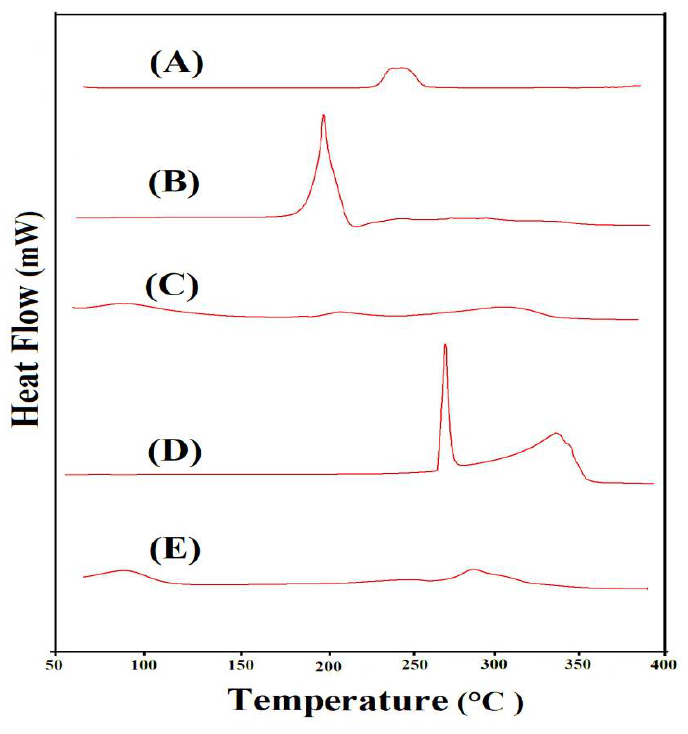
Figure 4. DSC of (A) ASPA, (B) AMPS, (C) ASPA-pAMPS microgels (AFn-3), (D) TP, and (E) loaded Figure 4. DSC of ( A ) ASPA, ( B ) AMPS, ( C ) ASPA-pAMPS microgels (AFn-3), ( D ) TP, and ( E ) loaded ASPA-pAMPS microgels ASPA-pAMPS microgels (AFn-3).